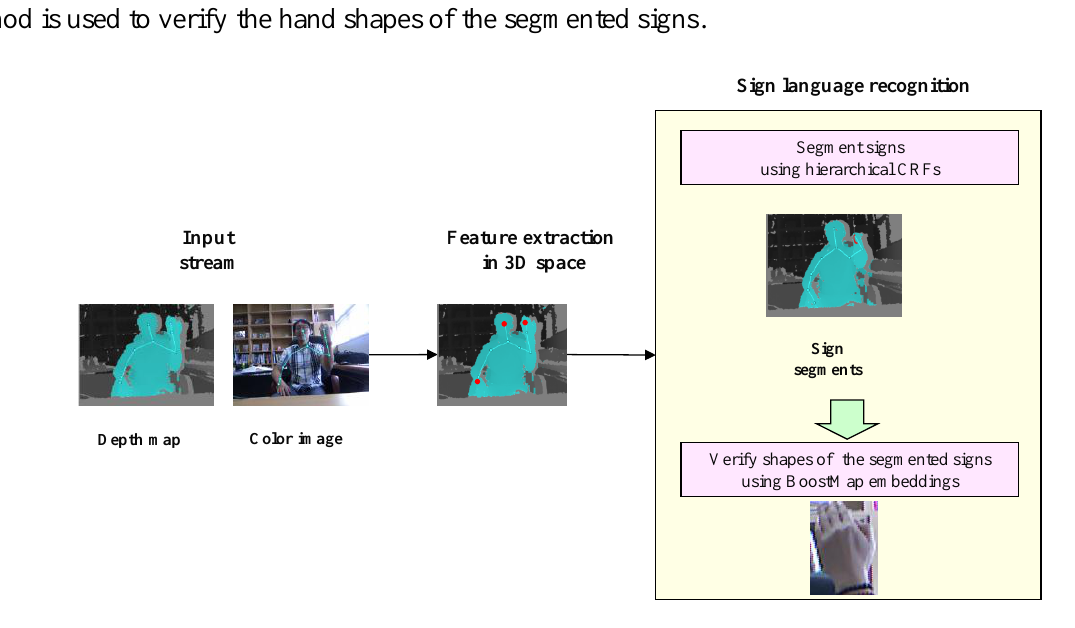
Figure 1. Overview of the proposed method for recognizing a